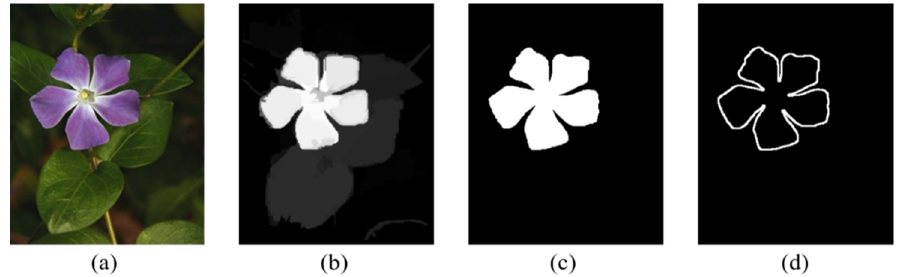
Figure 7. Results of boundary detection: ( a) input image, ( b ) saliency map, ( c ) the proposed saliency cuts approach, ( d ) outer boundary of a salient object.